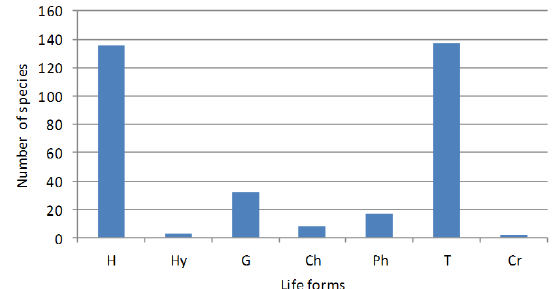
Fig. 4. Frequency of species of plant life forms in Kaseh-Garan area, Gilaneghaeb county: H) Hemicryptophyte; Hy) Hydrophyte; G) Geophyte; Ch) Chamaephyte; Ph) phanerophyte; T) Therophyte; Cr)